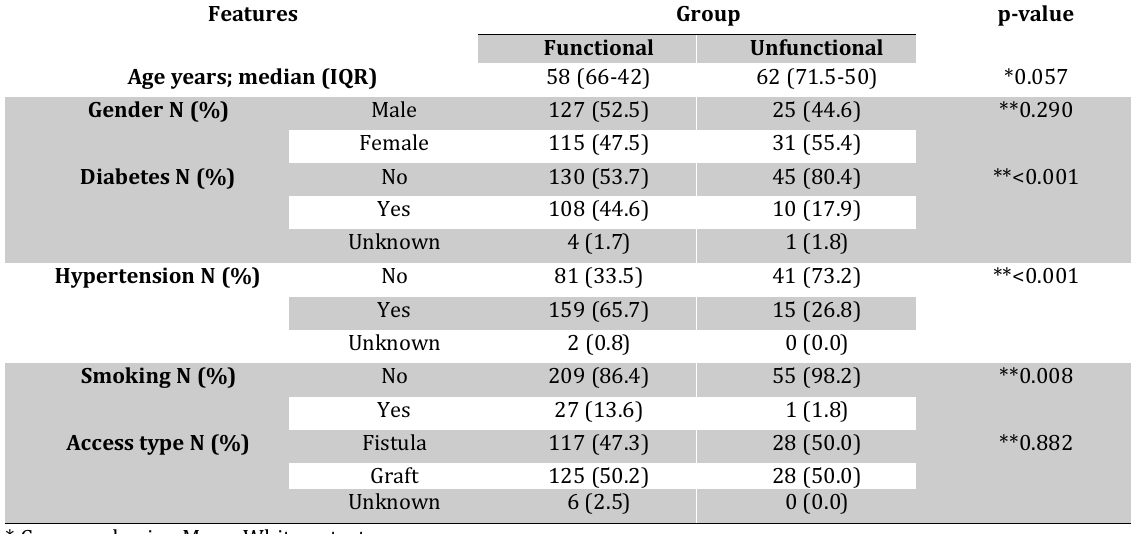
Table 1. Comparing age, gender, underlying disease, smoking, and access type between functional and unfunctional groups.